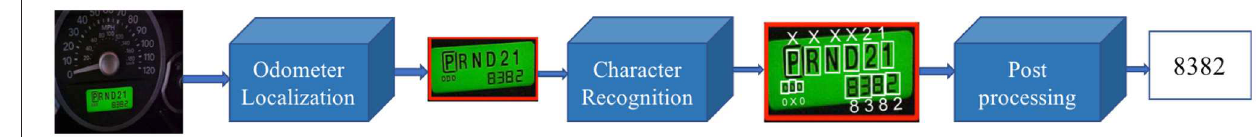
FIGURE 6 | Pipeline of proposed architecture.